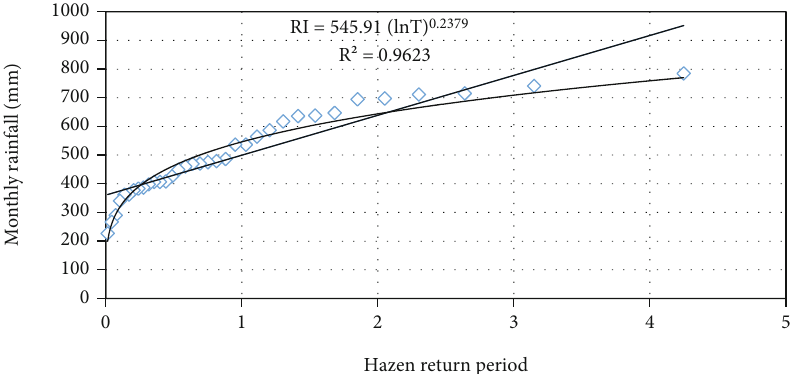
Figure 5: Hazen ’ s probability plotting